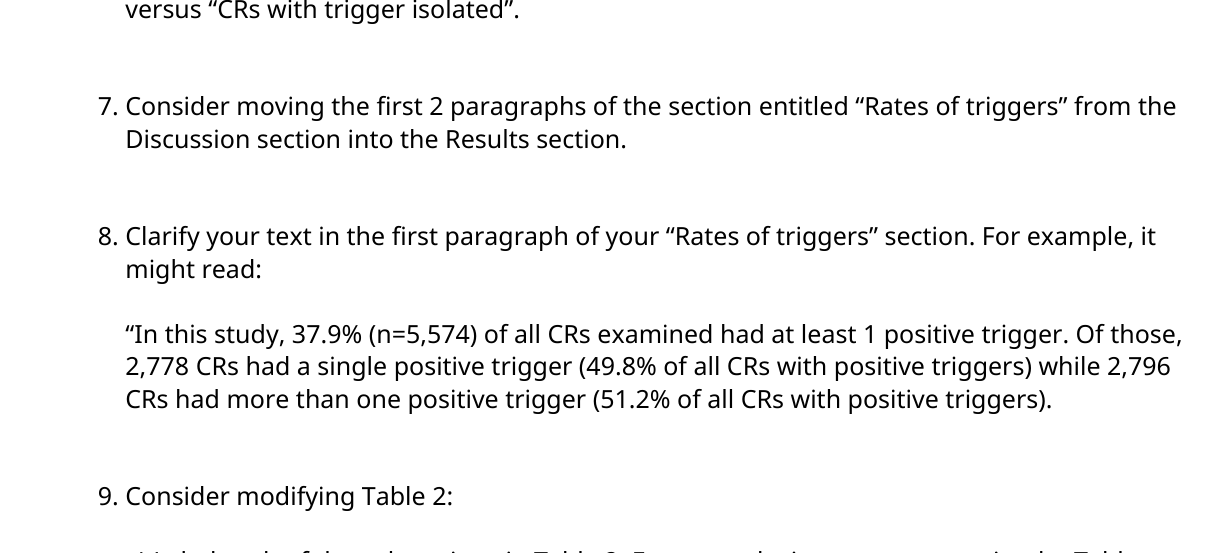
Table 1: Please clarify – I can’t understand what you mean by the phrases “CRs with triggers per inpatient wards” versus “CRs with trigger isolated per wards”; or “CRs with trigger” versus “CRs with trigger